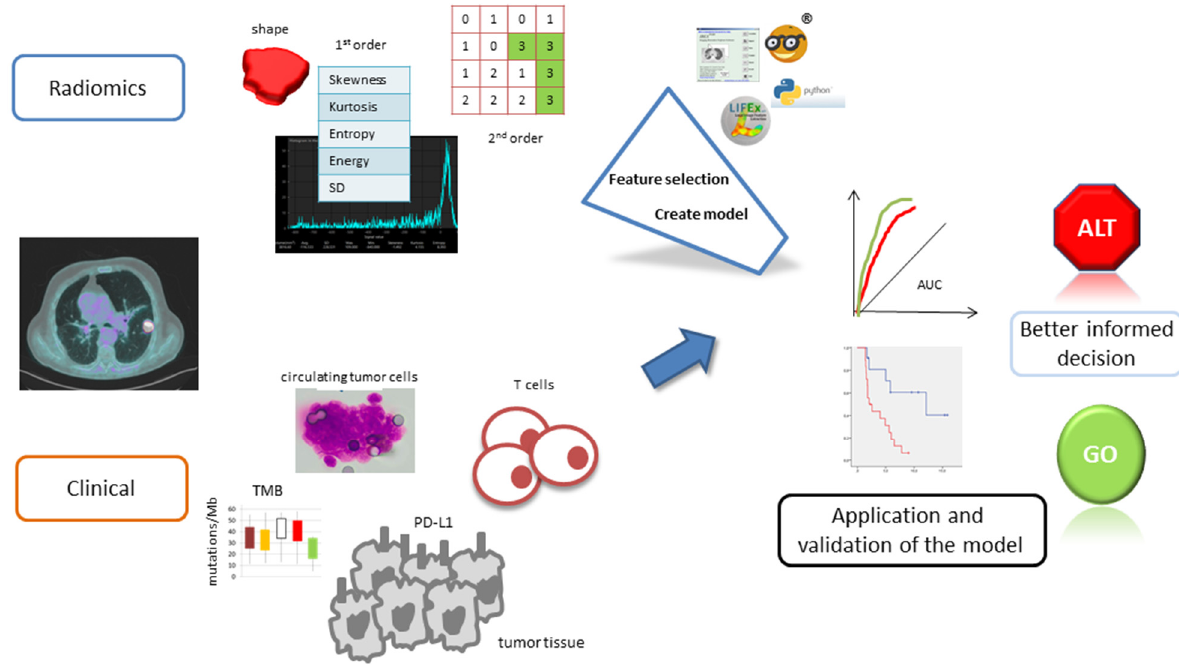
Figure 1. Illustration of the main steps involved in radiomic analysis and model development.